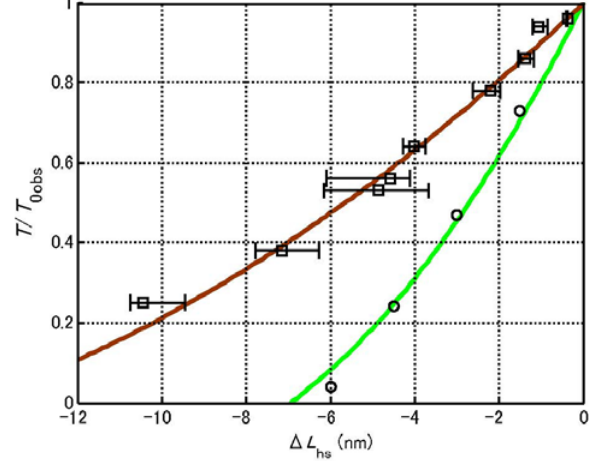
Figure 9. T / T vs.  L relations in Phase T1 and Phase V1. Circles: experimental 0obs hs